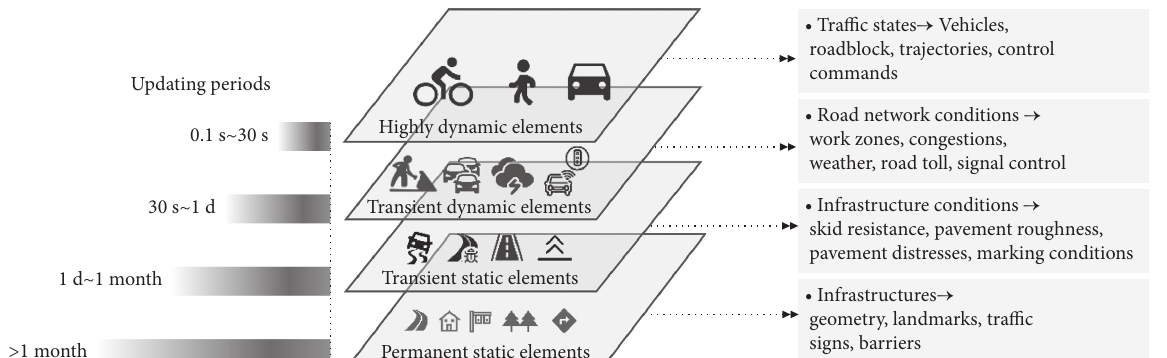
Figure 5: Basic elements of